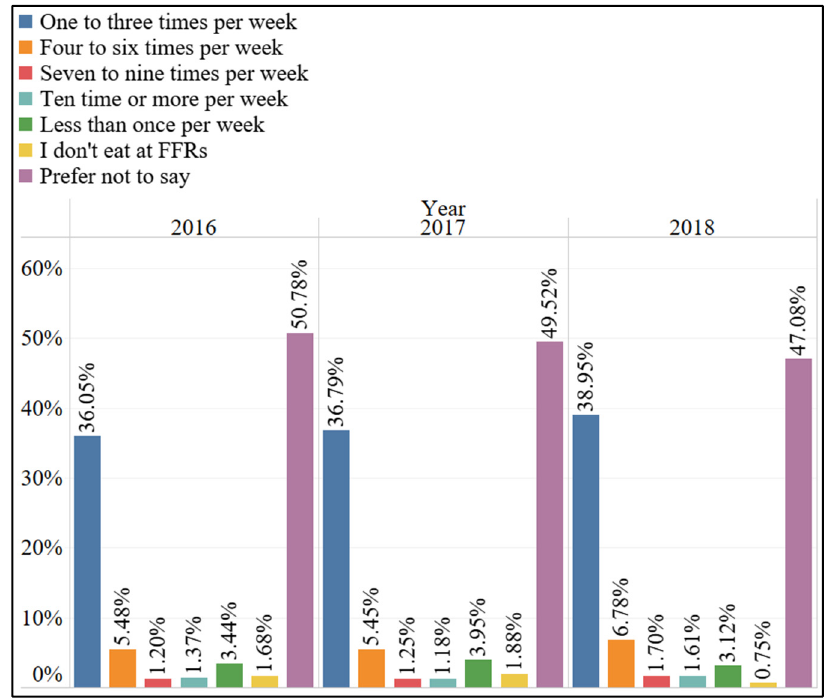
Figure 1. The frequency of Malaysians consuming food at FFRs in any given week. Source: Statista Research Department.